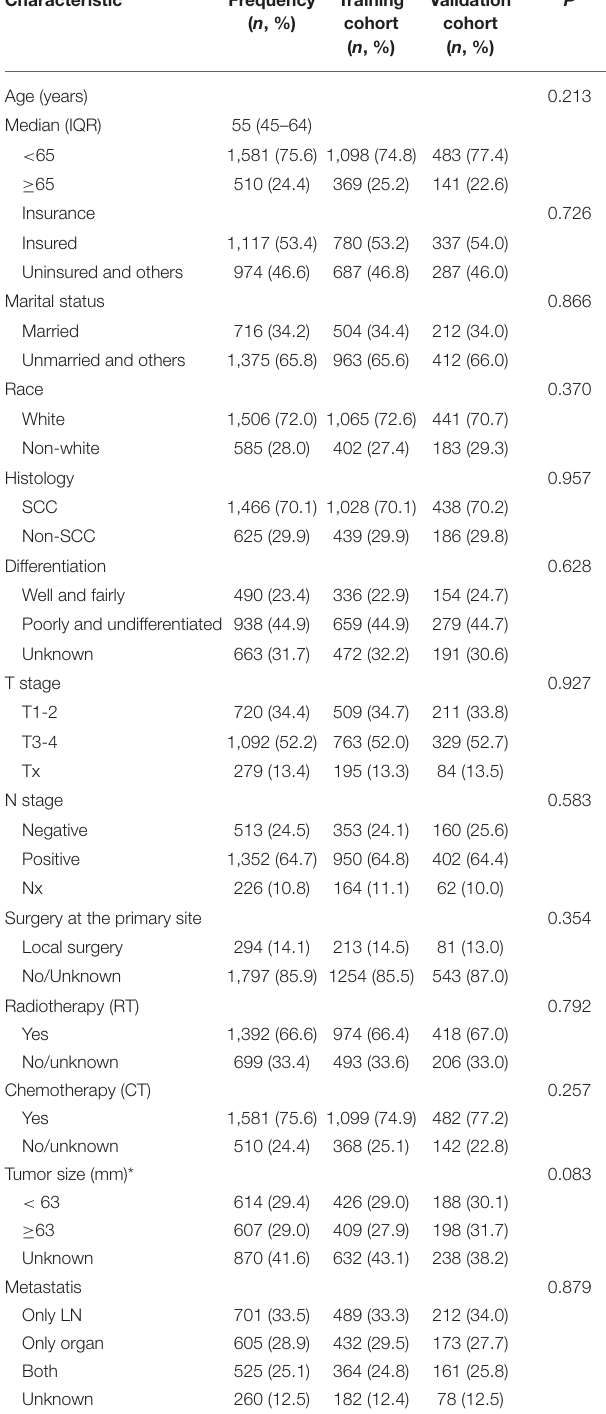
TABLE 1 | Baseline characteristics of the mCC